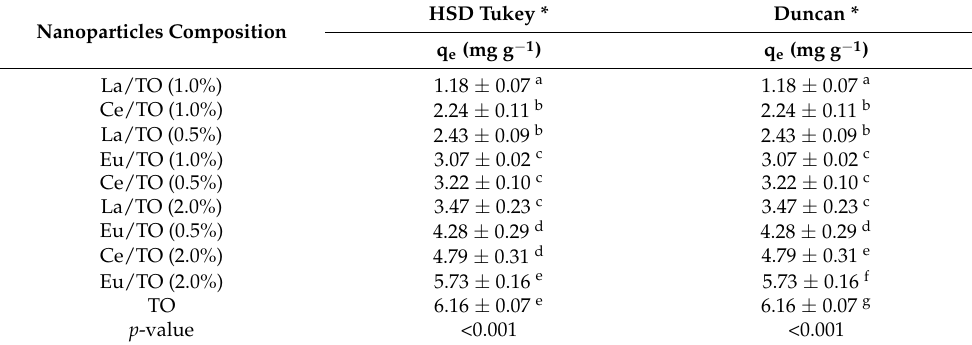
Table 1. Effect of nanoparticles compositions on their cyanide adsorption capacity.